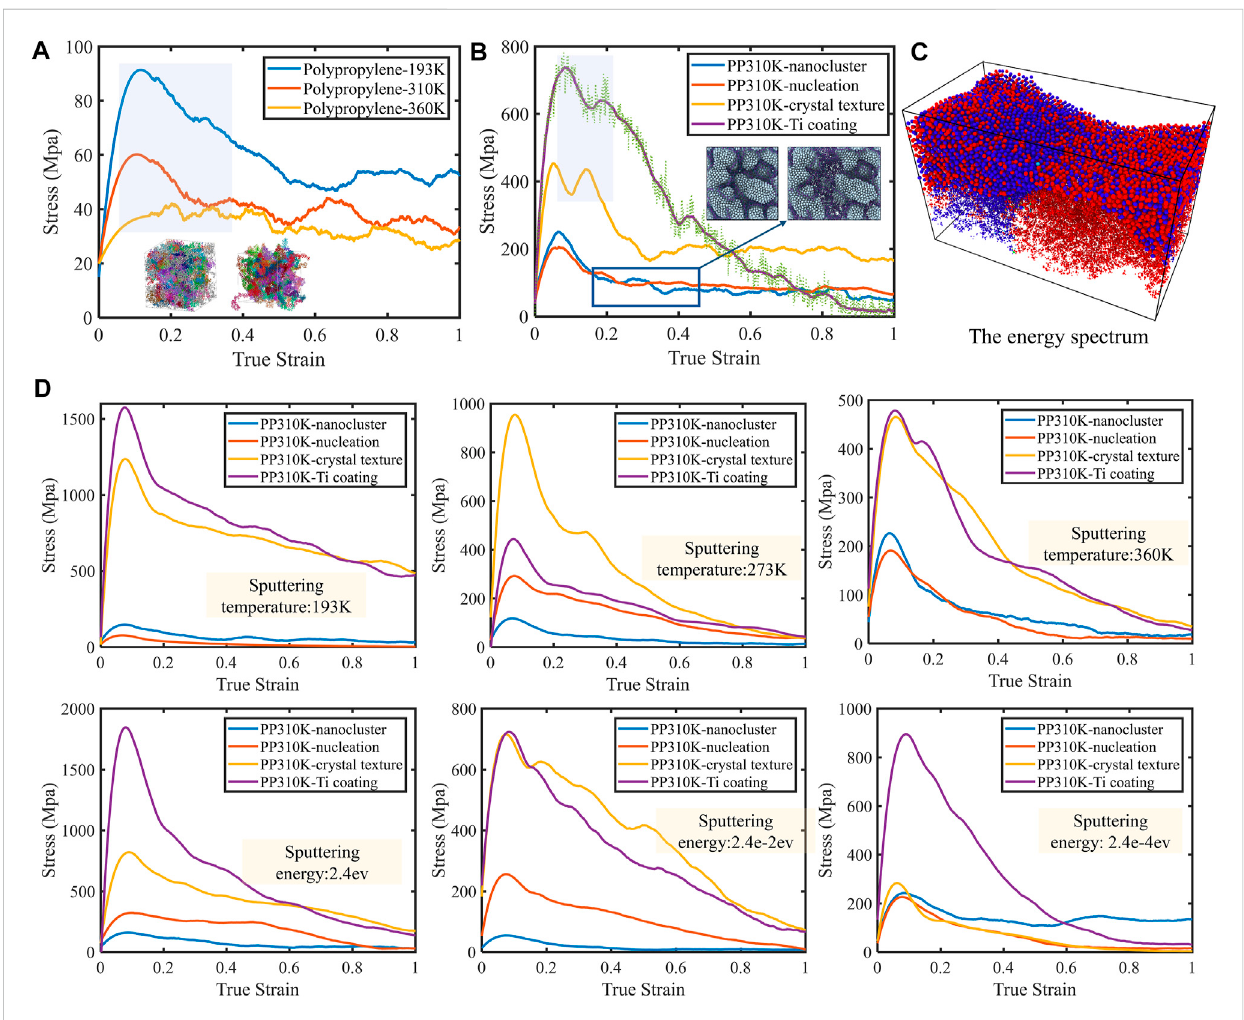
FIGURE 4 (A) The effect of temperature on the stress-strain behavior. (B) Characteristic evolution of the interface during stretching. When no homogeneous membrane-likemetal fi lmisformed,thereisessentiallynochangeintheagglomerates duringstretching,whenthemovementofthemolecularchainsis predominant. (C) Schematicdiagramofthechangeinparticledisplacementduringstretching.Asthedisplacementincreases,thecolorgraduallychanges from blue to red, indicating a signi fi cant change in the position of the lower polypropylene layer. The longer polypropylene chains undergo great deformation, which involves a mechanism of decoupling. (D) The effect of different surface roughness and crystal structures as well as different periods on the mechanical